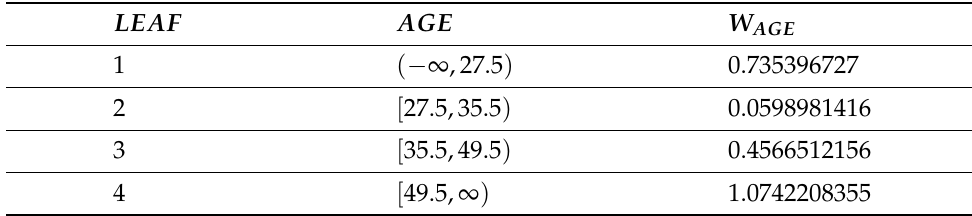
Table 2. Values obtained for W AGE from the tree depicted in Figure 4 (left).